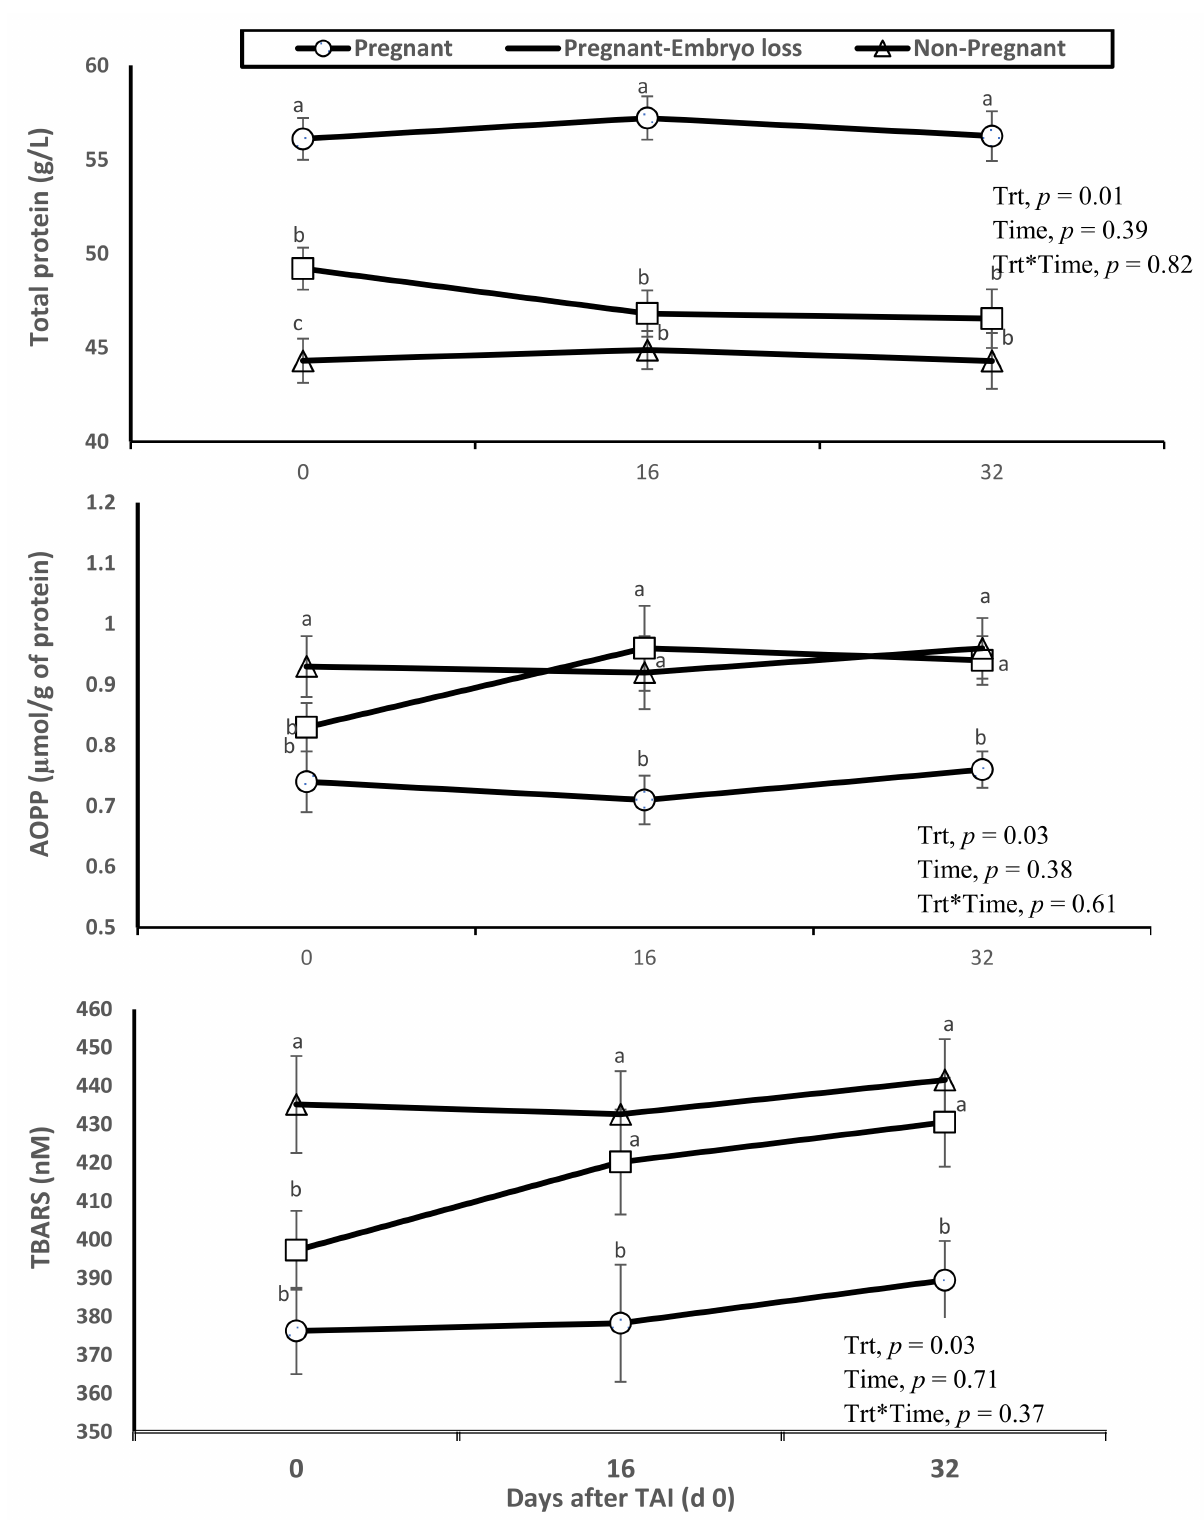
Figure 1. Changes in the systemic oxidative status (total protein content in plasma, advanced oxidation products of proteins (AOPP) and thiobarbituric acid reactive substances (TBARS)), of nonpregnant, pregnant and pregnant dairy cows with embryo loss between d 16 to 32 days after TAI (d 0). Values are means ± standard error of means. Different letters indicate a significant statistical difference in the specific day between the highlighted black symbols ( p <